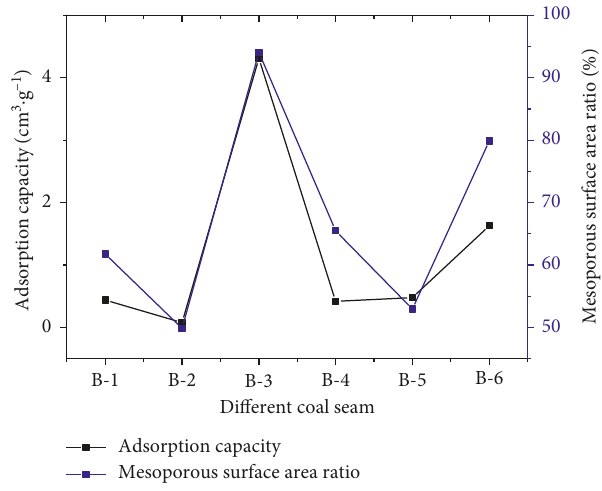
Figure 13: Adsorption capacity and mesoporous surface area for the B-1 to B-6 coal